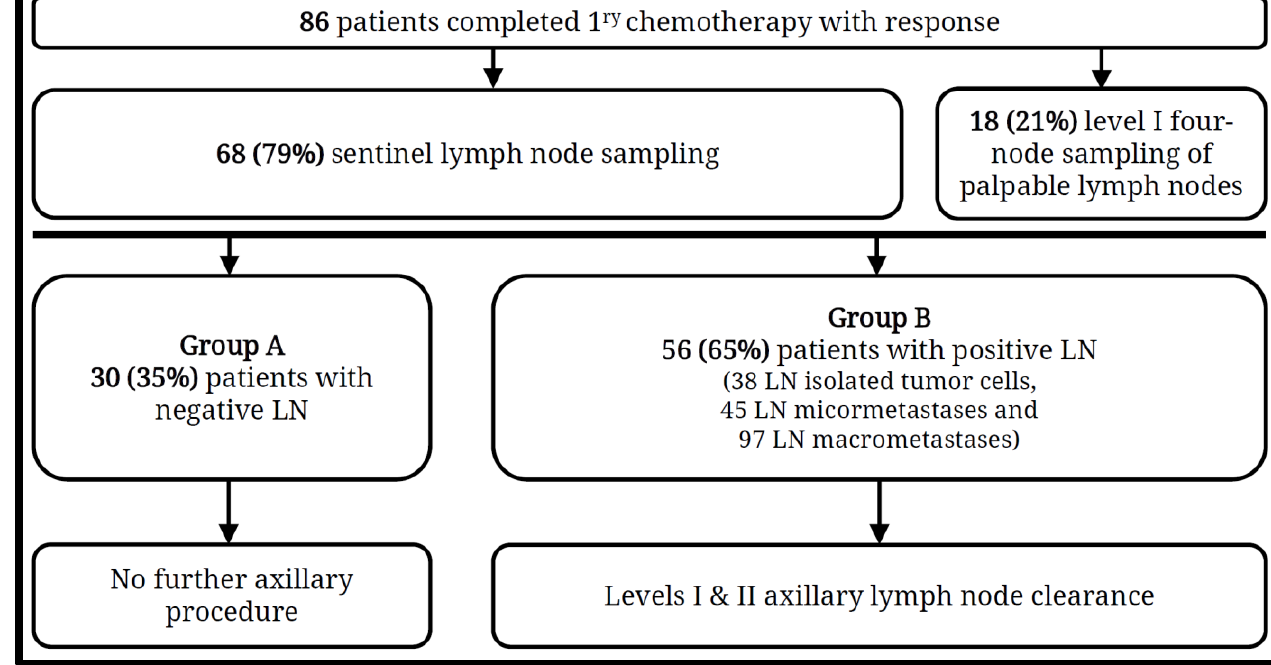
Figure 1: Outline of the management of 86 patients with invasive breast cancer While 56 (65.1%) patients had a partial radiological response, 30 (34.9%) had a complete radiological response on the mid and end of treatment breast ultrasound. The postoperative histological assessment showed a partial response in 60 (69.8%) patients and a complete response in 26 (30.2%) (26